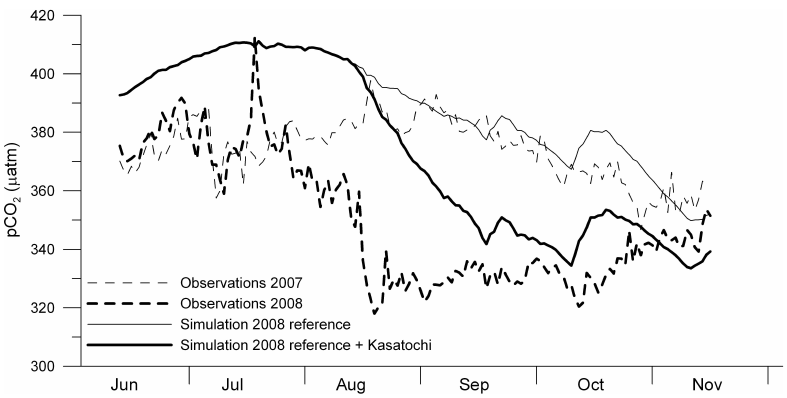
Fig. 13. Measured and simulated p CO 2 , SW in surface seawater at Papa. Measurements are shown for the year 2007 and 2008. Model results represent the year 2008 without and with considering iron deposition with volcanic ash fall.